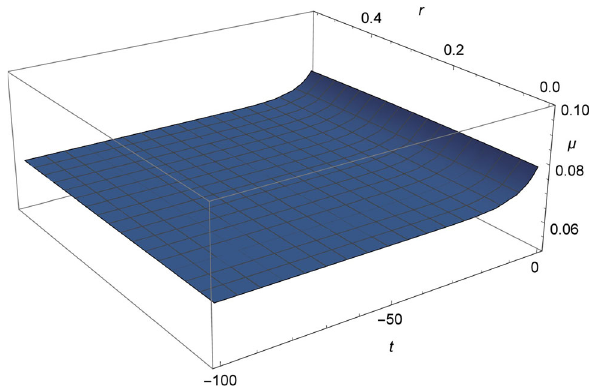
Fig. 1 Total density, c 1 = 0 . 81, c 2 = 0 . 5, c 3 = − 10, c 4 = − 10, ζ = − 0 . 2, R = 6 . 62, r = 0 . 55 and (cid:7) = 0 . 1 0